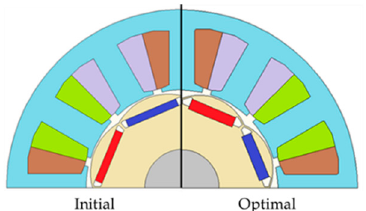
Figure 9. Comparison of initial and optimal models.